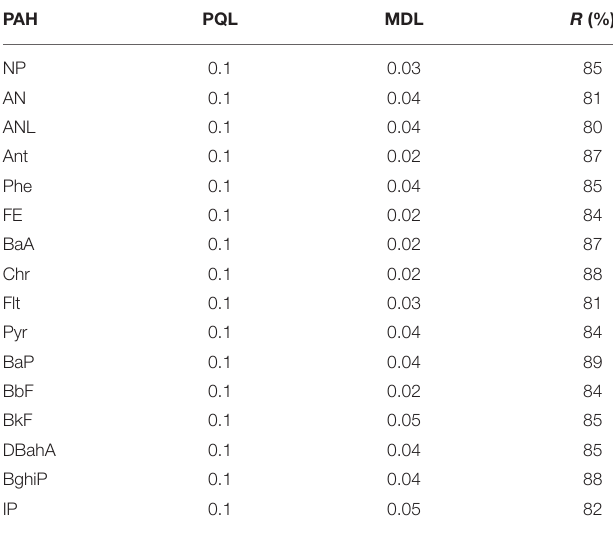
TABLE 3 | Practical quantification limits (PQL), method detection limits (MDL), and recovery (R) of PAHs in the soils and vegetables ( µ g kg − 1